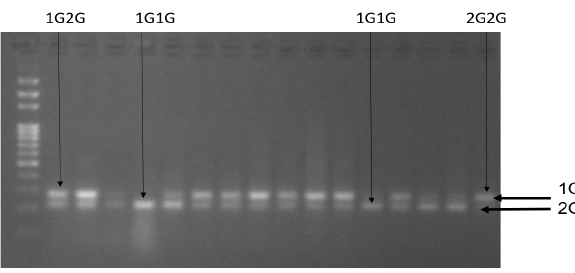
Figure 2 : UV revealed agarose gel showing MMP3 gene bands